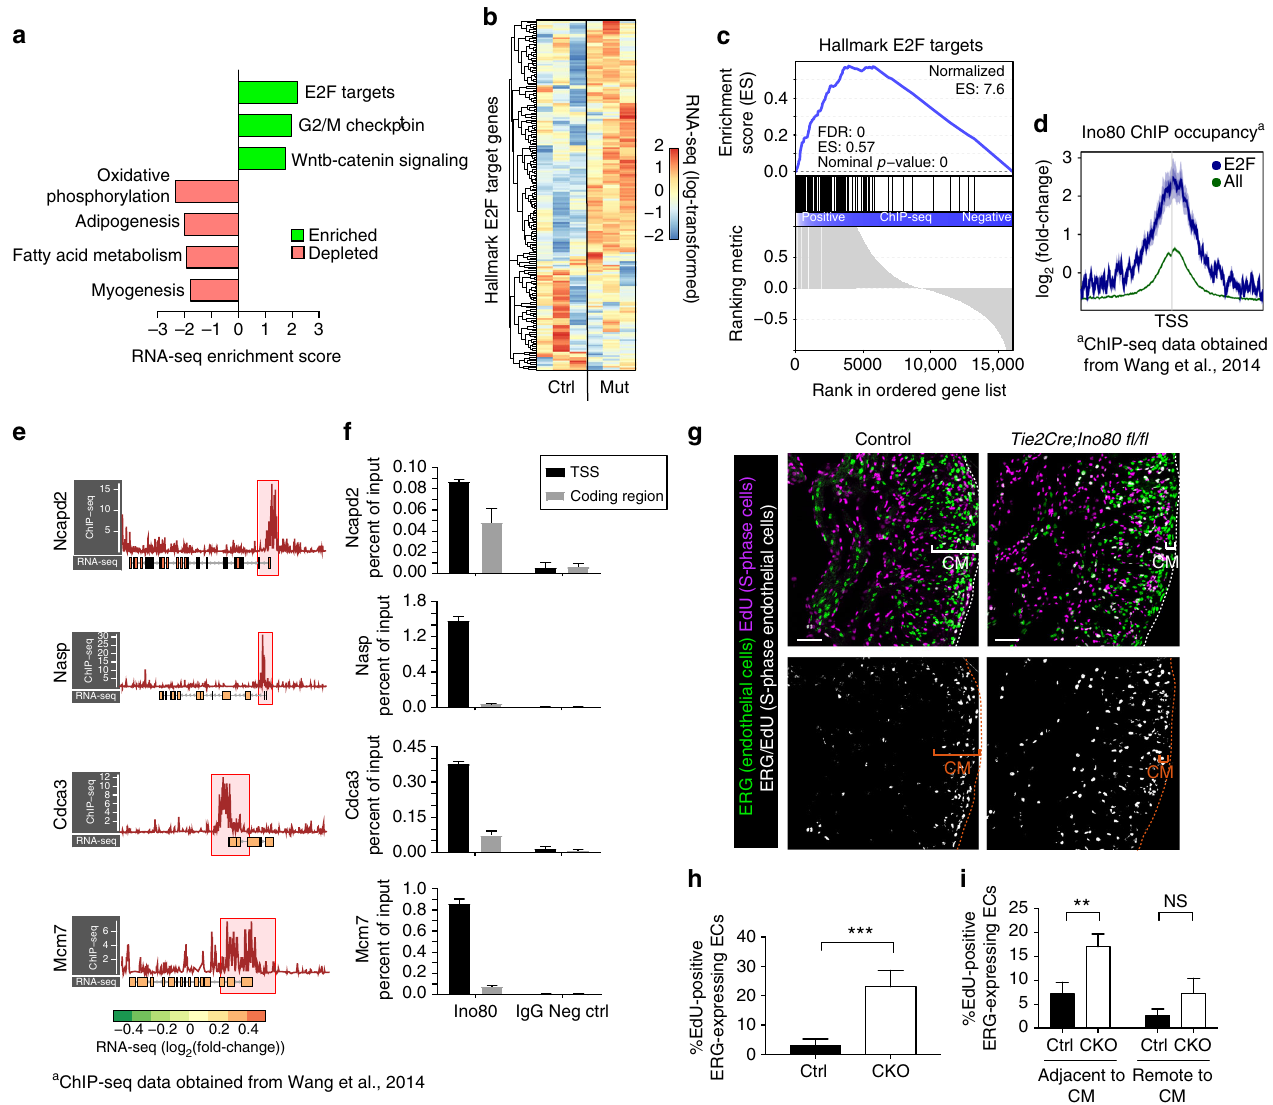
Fig. 7 Deletion of Ino80 increases E2F-regulated gene expression and endothelial S-phase progression. a GSEA of transcriptional changes in Tie2Cre;Ino80 fl / fl hearts compared to control hearts. All signi fi cantly enriched hallmark gene sets are shown with corresponding normalized enrichment scores (ES). b Heatmap of hallmark E2F target gene expression in each of three control (ctrl) and three Tie2Cre;Ino80 fl / fl mutant (mut) e13.5 hearts. Each column represents RNA-seq from an individual heart. Color represents regularized-log-transformed counts after scaling by row (i.e., gene). (Control n = ( c ) GSEA analysis of Ino80 ChIP occupancy in hallmark E2F target gene promoters in J1 ESCs. d Composite pro fi les of Ino80 occupancy at hallmark E2F target gene promoters (blue line) compared to the genome-wide average (green line). e Ino80 ChIP occupancy and corresponding RNA-seq expression changes at individual E2F-dependent loci. ChIP-seq signals (red line, -log 10 -pval) and promoters (red boxes, 1.5 kb upstream and 2 kb downstream of TSS) are shown. Mutant RNA-seq data (log 2 [fold change]) is represented by color of exon. f Ino80 ChIP enrichment at transcriptional start sites (TSSs) and coding regions for indicated genes in HUVECs. Rabbit IgG is shown as a negative control. ChIP-qPCR results are shown as percent of input. Standard deviation was calculated from three technical replicates. g EdU incorporation assays show that endothelial cells have an increased number of cells in S-phase. Top panels show immuno fl uorescence to label endothelial cells (ERG) and EdU positivity (green). Bottom panels show overlap between the two signals. Images are representative of the following number of replicates: control, n = 4 hearts, mutant, n = 3 hearts. Scale bars: 100 μ m. h , i Quanti fi cation of EdU-positive endothelial cells show there is a signi fi cant 10-fold increase at e15.5 (control, n = 4 hearts; mutant, n = 3 hearts) ( h ) and at e12.5 (control, n = 3 hearts; mutant, n = 3 hearts) ( i ) in cells adjacent to the compact myocardium. Error bars in graphs are standard deviation. NS nonsigni fi cant, ** P < 0.01; **** P < 0.0001, evaluated by Student ’ s t -test. CM compact